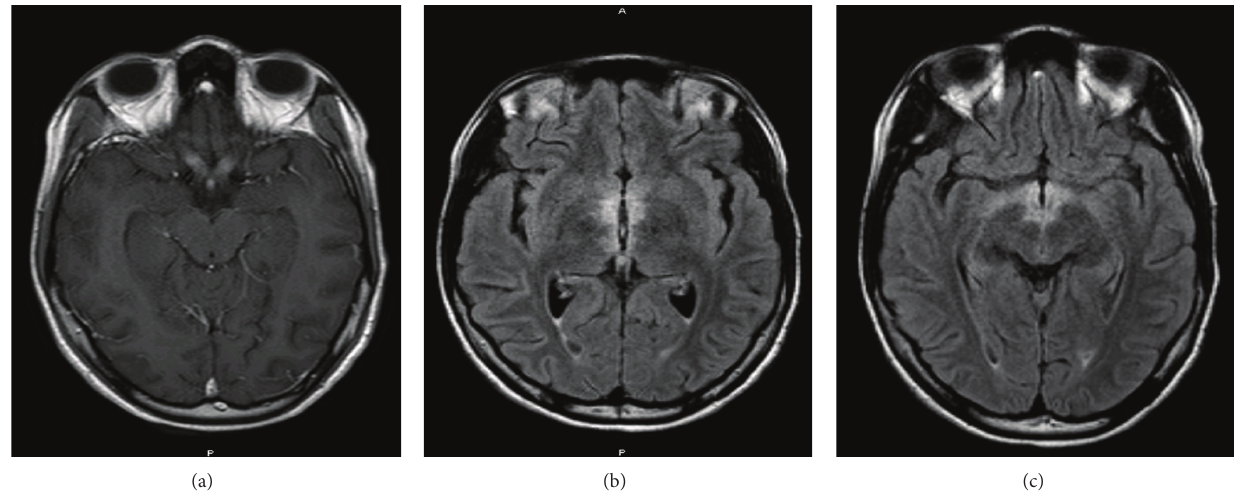
Figure 1: MRI of the brain: (a) axial T1W postcontrast: enhancement of bilateral optic nerves extending to the optic chiasm. (b) and (c): T2W FLAIR: increased signal in a symmetric fashion involving the hypothalami, mammillary bodies, periaqueductal gray matter, and posterior aspect of pons and medulla.